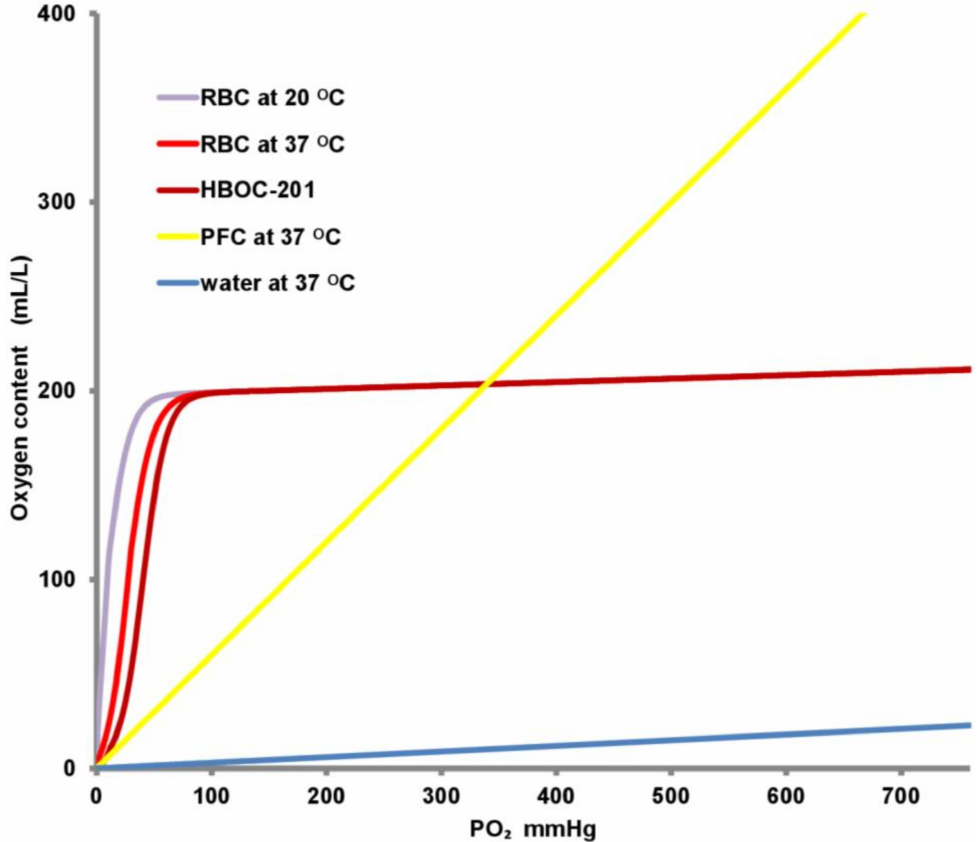
Figure 1. Graphical presentation of the relation between partial oxygen (PO 2 ) pressure and the O 2 content of different solutions. Note how poorly O 2 dissolves in water (blue curve). To achieve a useful O 2 content without an oxygen carrier, a saturation of 100% O 2 is required, i.e., a partial pressure of 760 mm Hg. Perfluorocarbons (PFC; yellow curve) can dissolve 20 times more O 2 . The red blood cell (RBC) and hemoglobin-based oxygen carrier-201 (HBOC-201) curves assume a concentration equivalent with 7.76 mmol/L of O 2 binding places [30]. Additionally, note that the only small apparent shifts in the dissociation curves result from the supraphysiological PO 2 of 760 mmHg. When glucose is fully oxidized under steady-state conditions, the production of CO 2 ( ˙VCO 2 ) will be equal to the consumption of oxygen ( ˙VO 2 ). The ratio between ˙VCO 2 and ˙VO 2 is called the respiratory quotient (RQ) and can be monitored in vivo or during ex situ MP. It is an important indicator of how ATP is generated. Glucose oxidation has an RQ of 1, whereas lipid oxidation has an RQ of <0.8